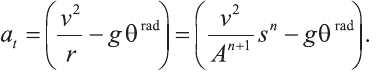
Figure 3. Planimetric scheme of the designed exit lanes (case studies 1−9)